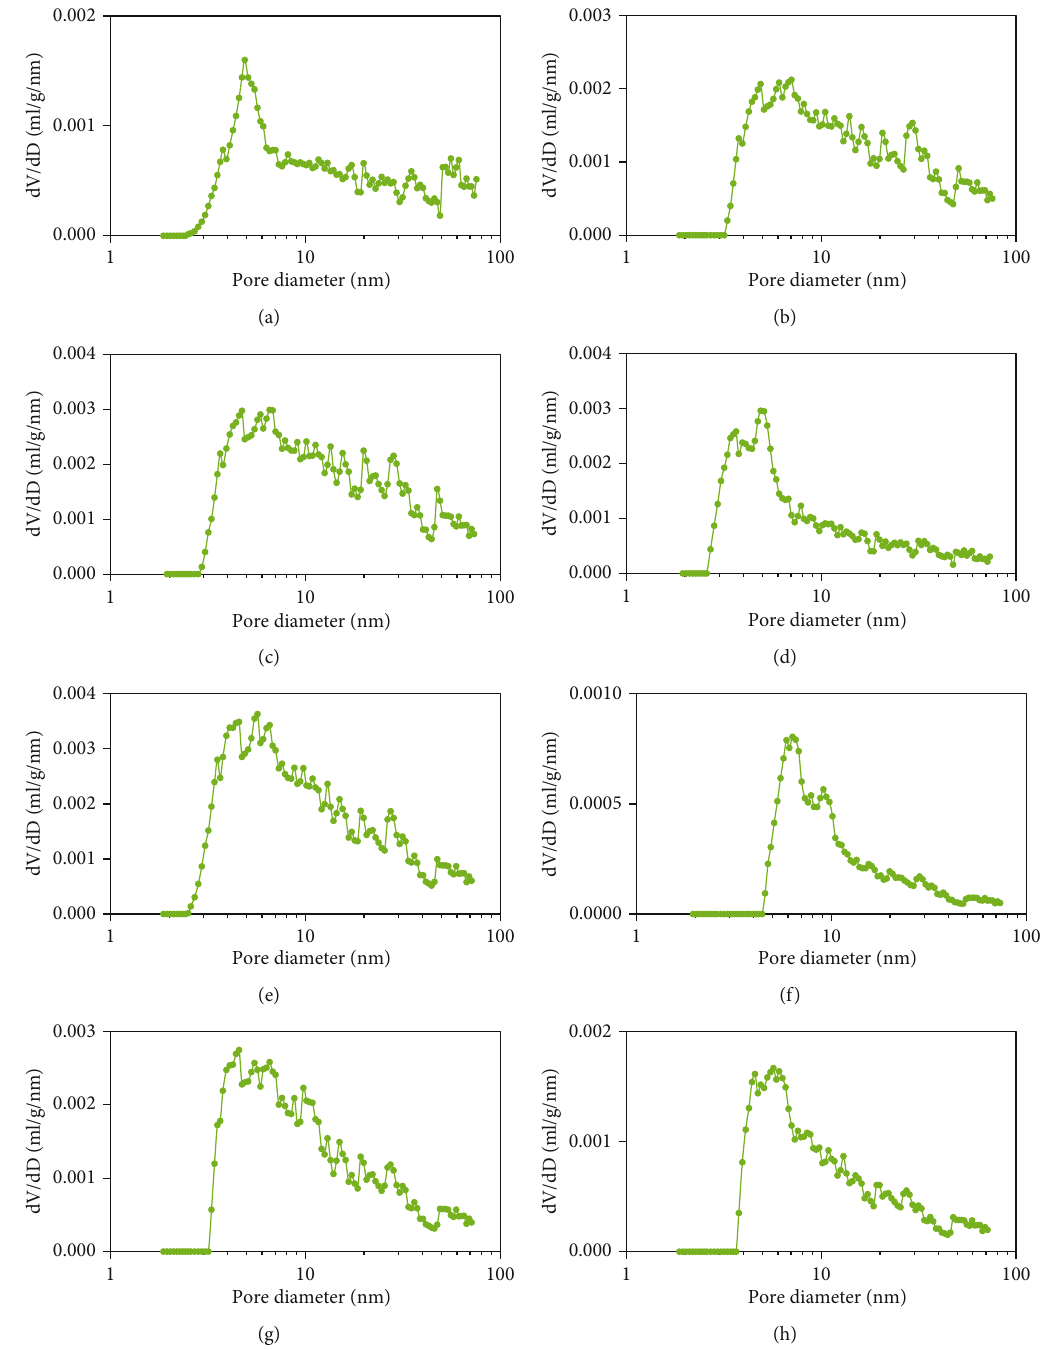
Figure 5: BJH desorption model pore volume distribution of Qigequan Formation mudstone samples. (a) H-1: pure mudstone; (b) H-2: pure mudstone; (c) H-3: pure mudstone; (d) H-4: silty mudstone; (e) H-5: silty mudstone; (f) H-6: silty mudstone; (g) H-7: sandy mudstone; (h) H-8: sandy